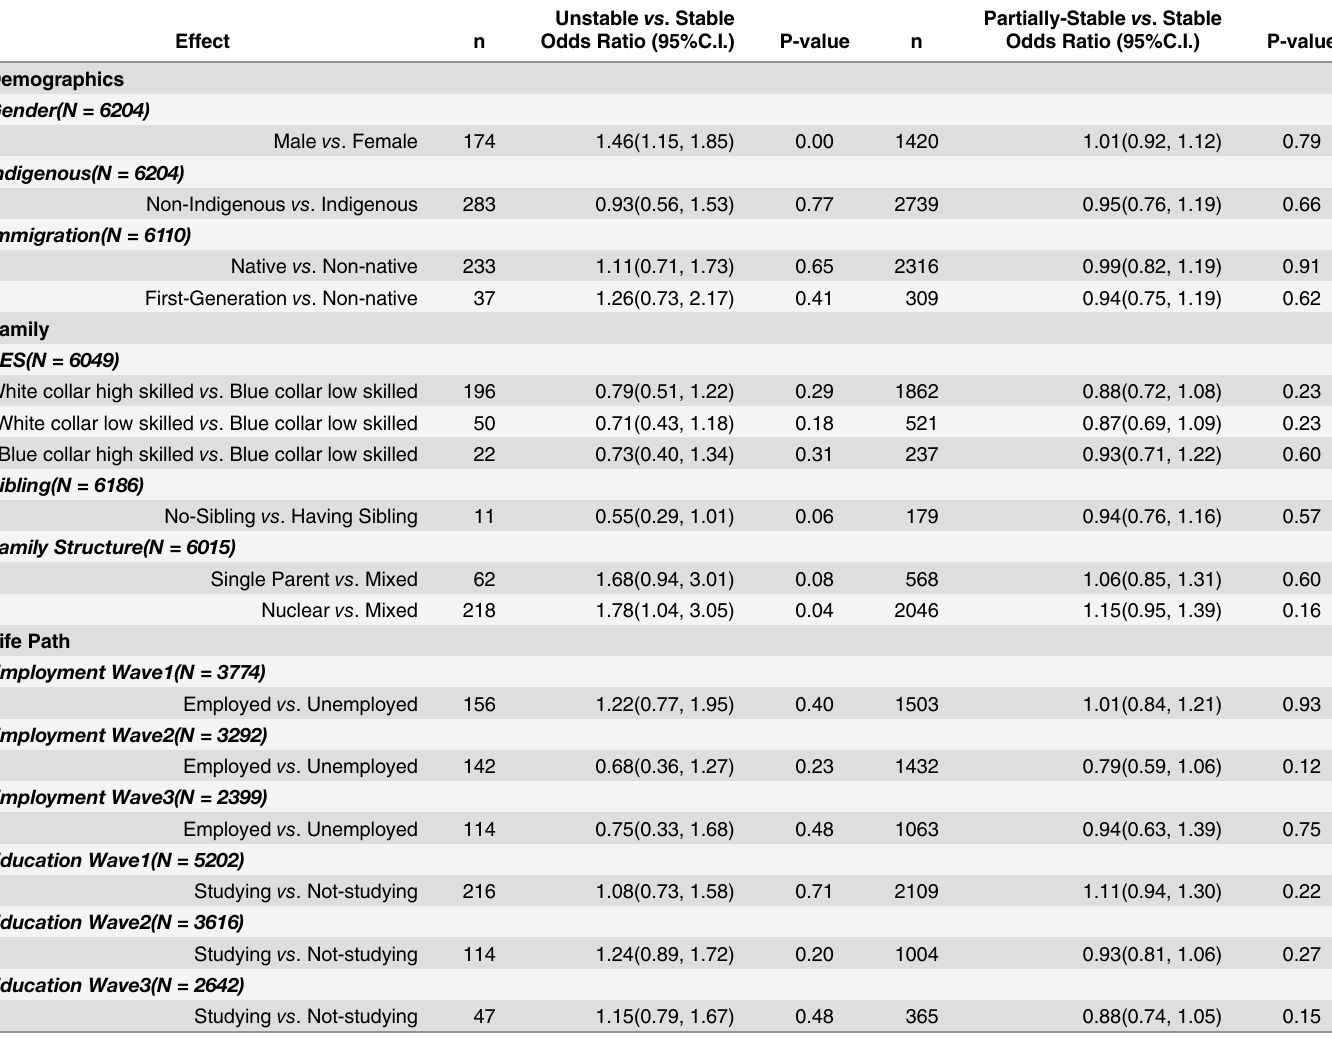
Table 3. Influences of Demographics, Family, Life Path on Stability of Transition Patterns for cohort 2003. Unstable vs .